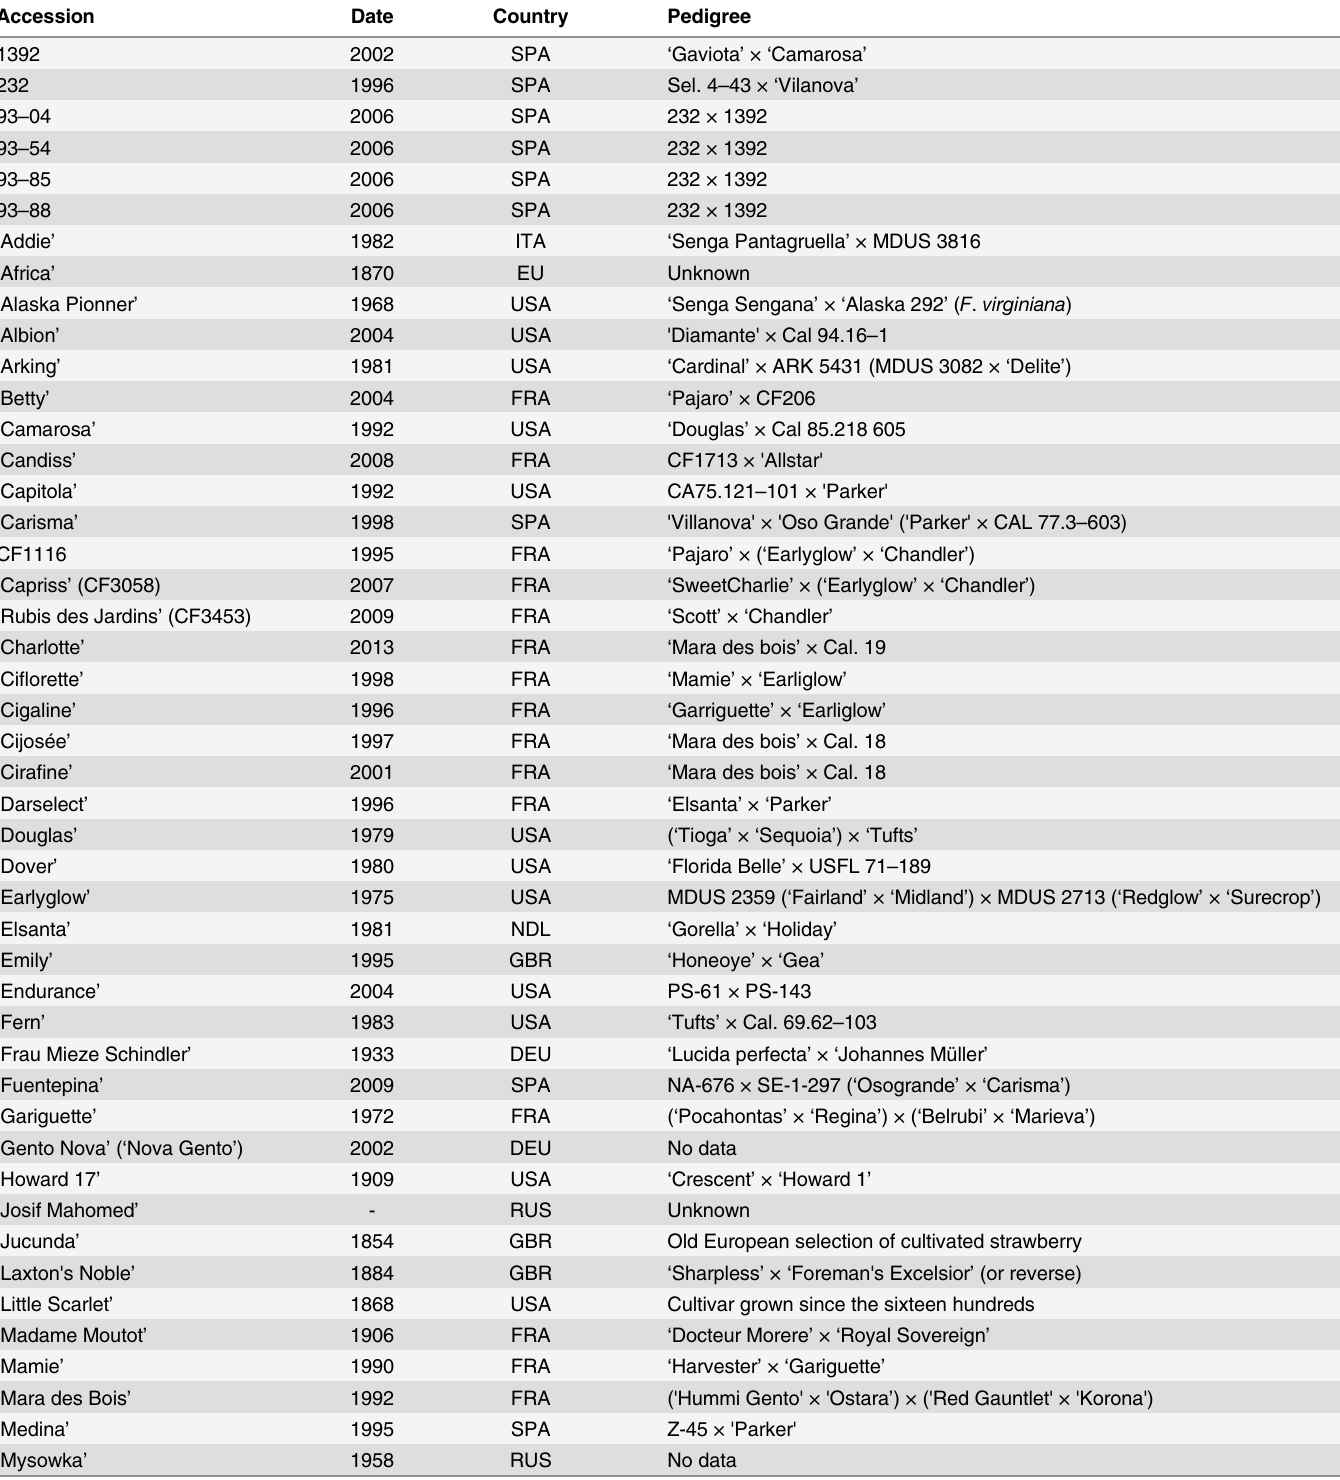
Table 1. List of Fragaria × ananassa germplasm used to evaluate the genetic diversity. The year of release, country of origin and pedigree is stated when